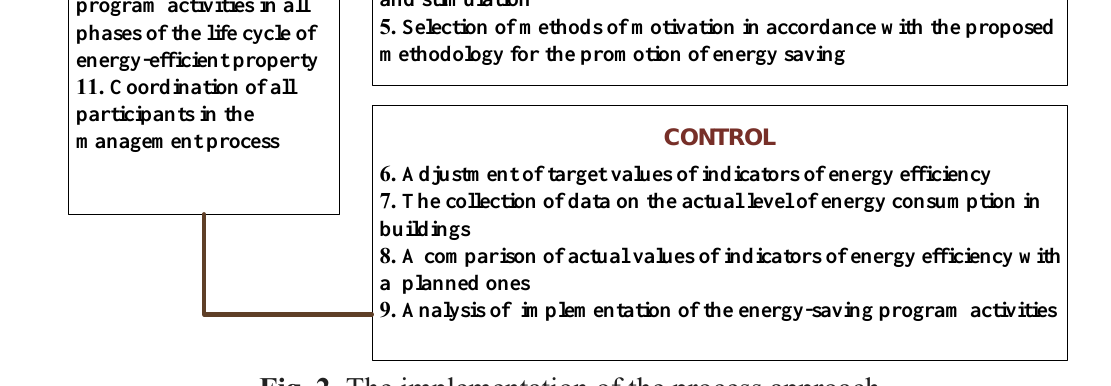
Fig. 2. The implementation of the process approach to the energy-saving